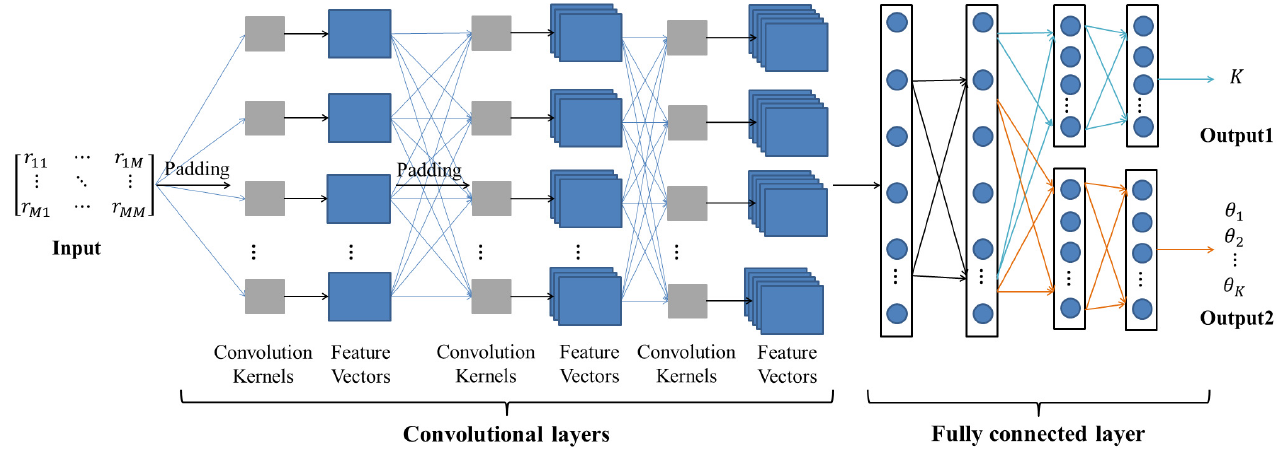
Figure 2. The structure of the CNN